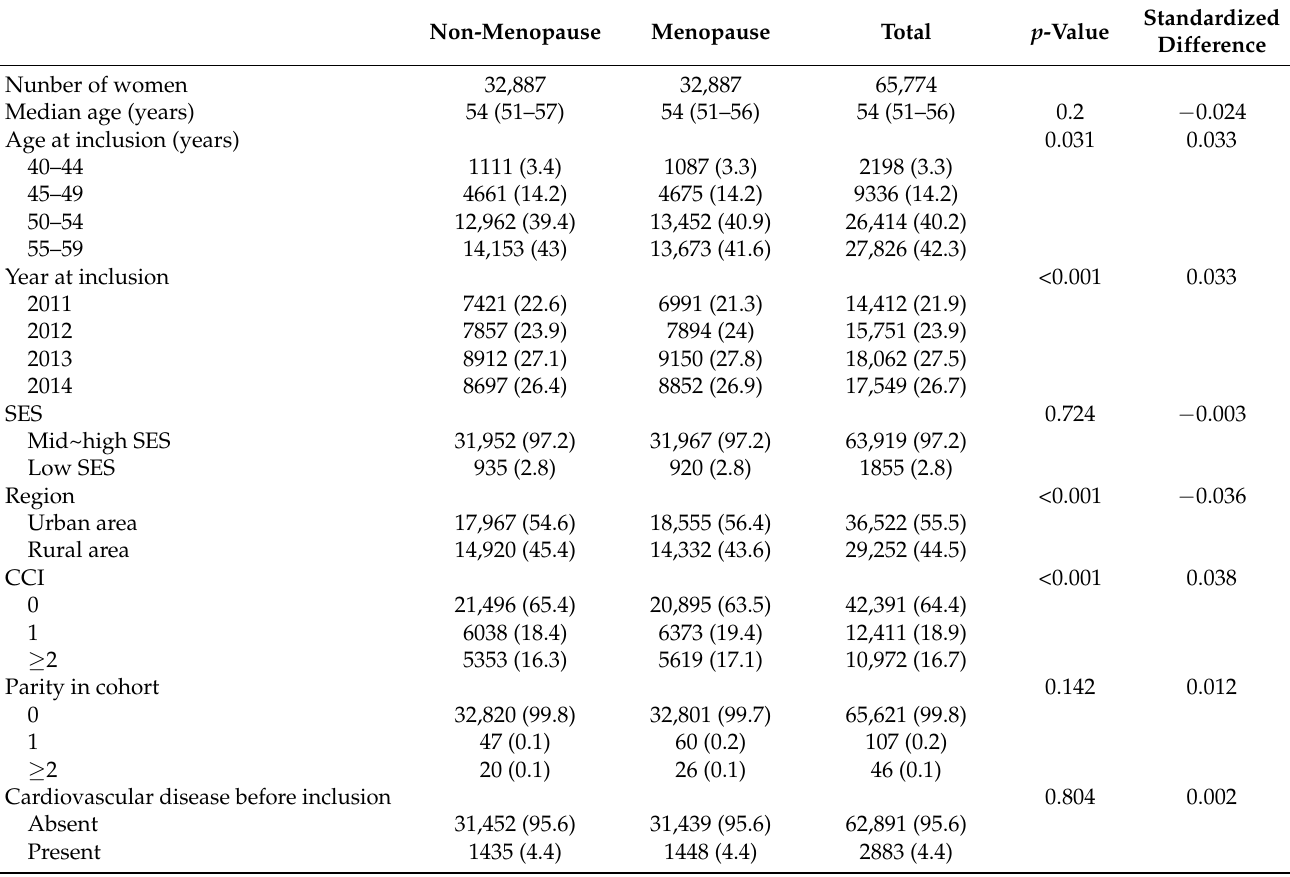
Figure 1. Flowchart for the selection of participants from the Korea National Health Insurance Database, 2007–2020. Table 1. Characteristics of participants according to whether or not menopausal status was performed after matching. Korea National Health Insurance Database, 2007–2020.